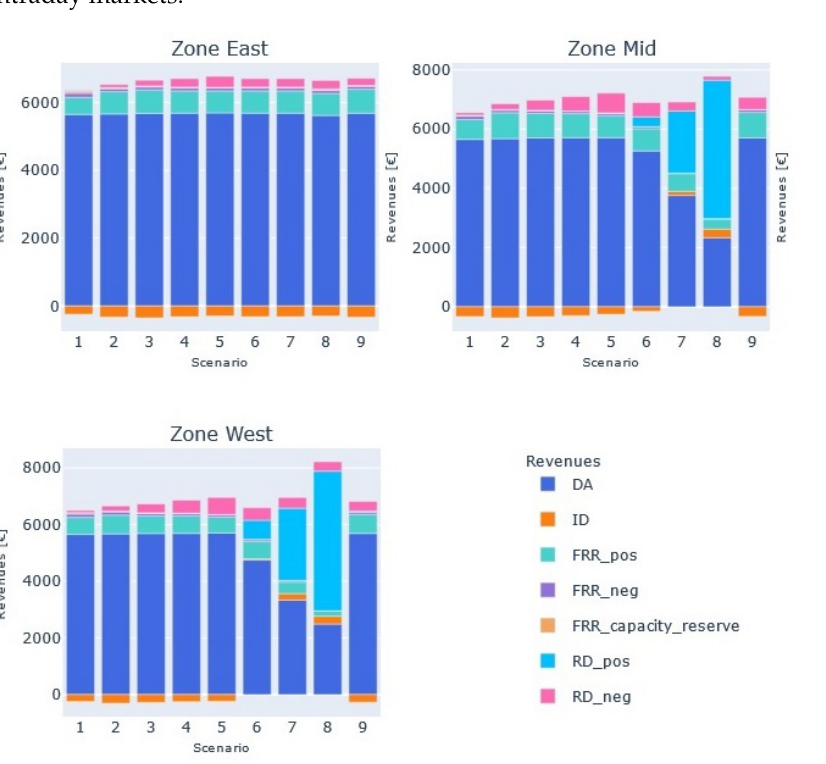
Figure 5. Total revenues for different scenarios in the three zones of Austria, varying the remuneration for downward (scenario 1–5) or upward (scenario 5–8) redispatch, related to the day-ahead price. Scenario 9 assumes a nodal pricing